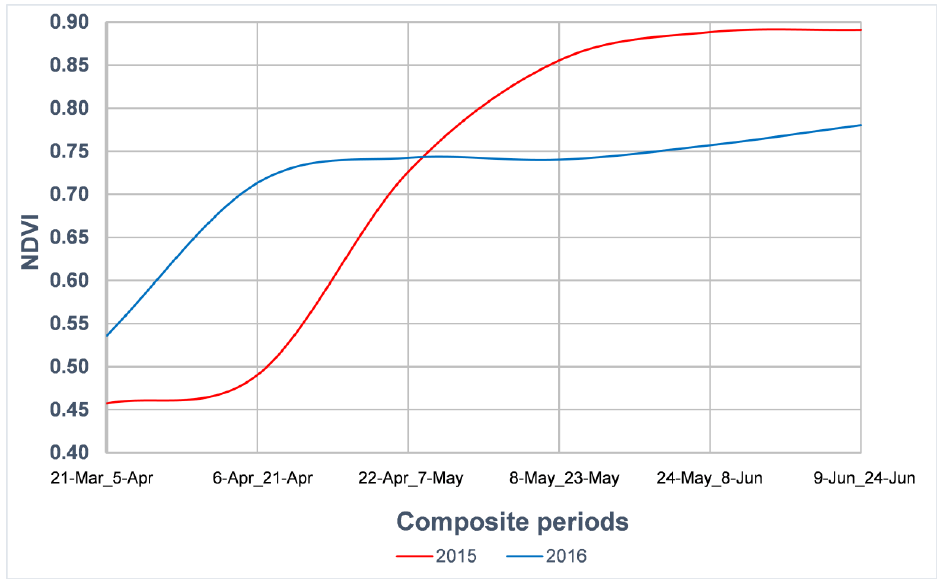
Figure 3. Pollino beech forest phenological profiles obtained from MOD13Q1 product (NDVI; Normalized Difference Vegetation Index) data for 2015 and 2016. For the ordinates of NDVI values (range 0:1), the abscissa dates correspond to the 16-day compositing periods of Moderate Resolution Imaging Spectroradiometer (MODIS) data (using dates for 2016, which is a leap year; for the non-leap year 2015, dates should be advanced by one day).